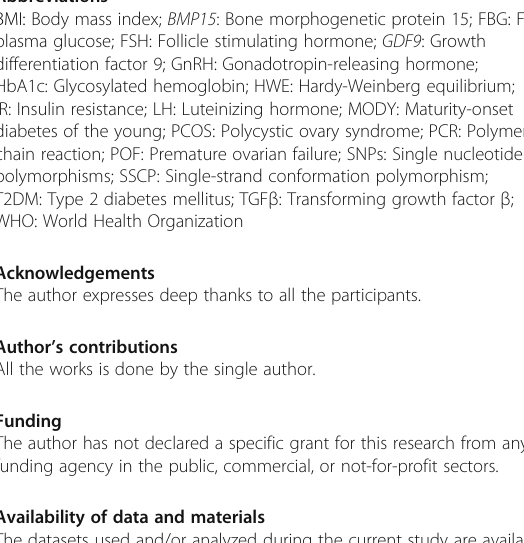
Supplement Table 2. SSCP electrophoresis conditions of the amplicons of the GDF9 and BMP15 genes in studied populations. Supplement Table 3. Nucleotide substitutions and types of genotypes among SSCP banding patterns of the studied human population. The present annotations were based on GenBank accession number NC